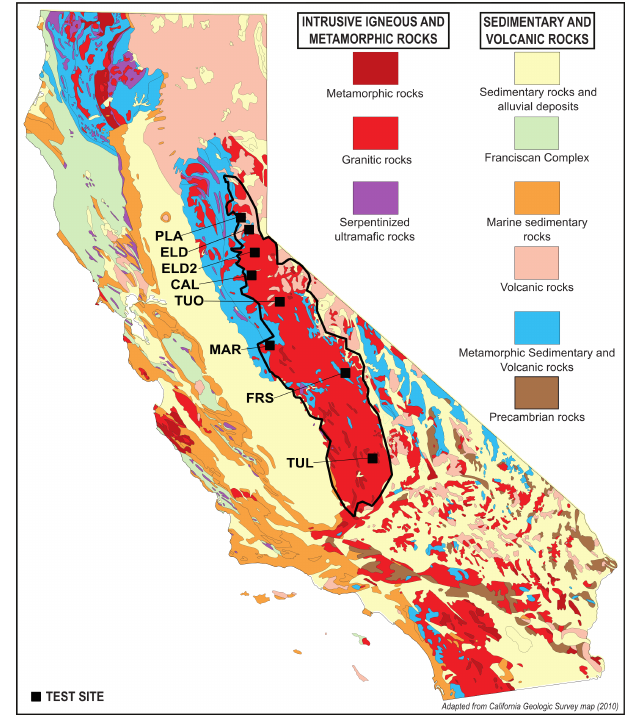
Figure 2. Simplified geologic map of California (adapted from [50]) with test sites marked (black squares). The model was trained and tested in the predominately granitic rocks (red) of the Sierra Nevada Mountains (black